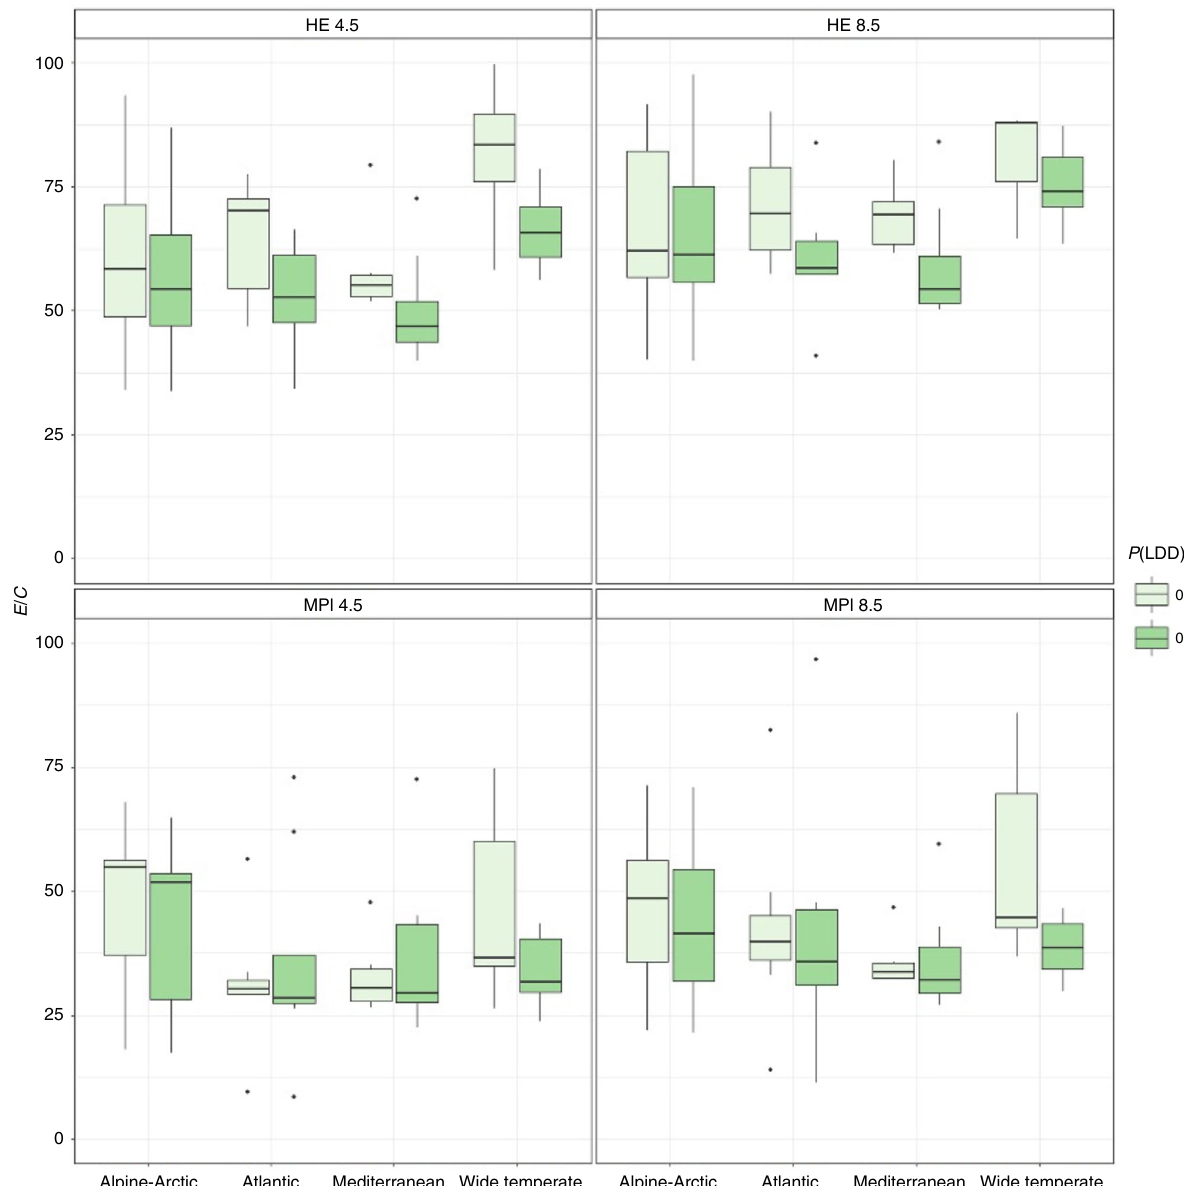
Fig. 3 Predicted rates of future extinction and colonization of areas becoming newly suitable due to climate change in European bryophytes. The box- plots (showing the 1st and 3rd quartiles (upper and lower bounds), 2nd quartile (centre), 1.5* interquartile range (whiskers) and minima-maxima beyond the whiskers) represent the ratio E / C , averaged over 30 MigClim replicates, between the predicted rate of range loss E (fraction of initially suitable cells that became unsuitable by 2050) and the rate of simulated effective colonization events C (fraction of newly suitable cells by 2050 that were effectively colonized) in 40 selected bryophyte species from the four main biogeographic elements in Europe. Results are shown for two selected dispersal kernels (release height set depending on species habitat preferences, maximum wind layer, and long-distance dispersal probability of 0 and 0.1), two global circulation models (MPI: MPI-ESM-LR and HE: HadGem2-ES) and two climatic scenarios (RCP4.5 and